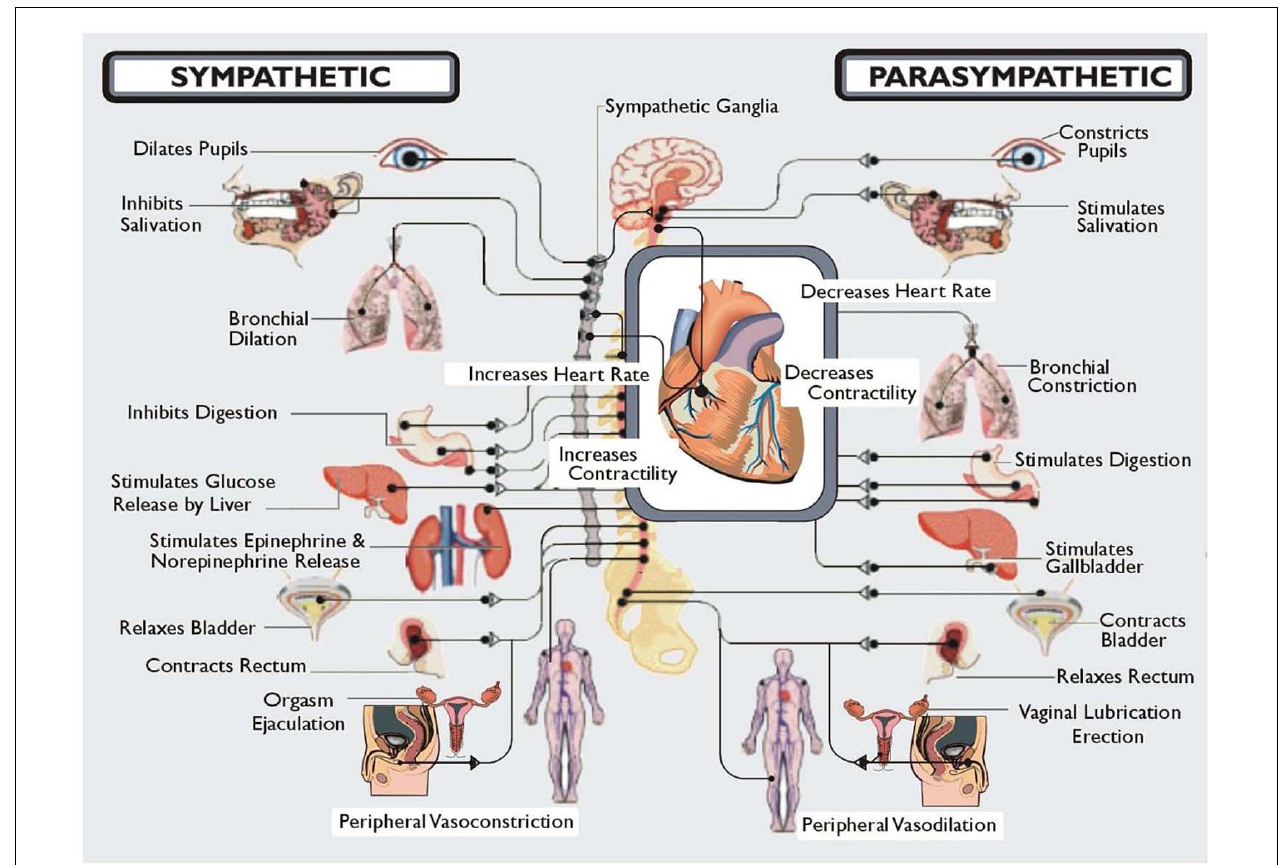
cholinergic anti-inflammatory pathway adding yet another dimension to the role of the autonomic nervous system in survival of the organism. Note that KurtVonnegut recognized the importance of the CNS in stress but failed to recognize its role as the conductor of the endocrine and autonomic orchestra. But then he was not a